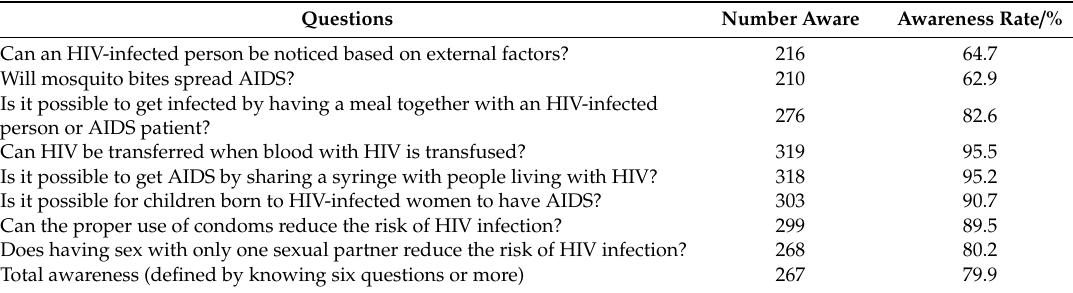
Table 2. Awareness rate of AIDS knowledge.